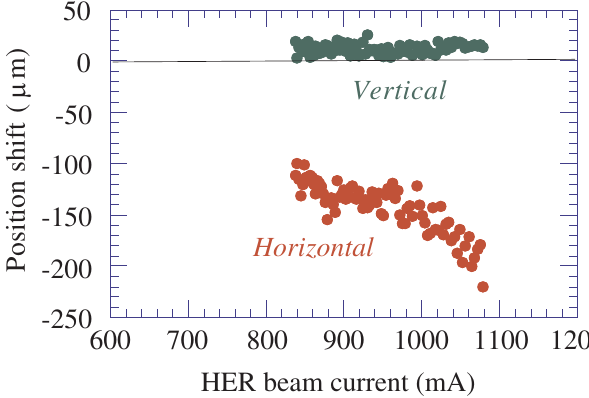
FIG. 5. (Color) Horizontal (red) and vertical (green) position shifts at LER-2 as a function of the HER total beam current, measured in a physics run in December 2003, where a peak luminosity of 1 : 1 (cid:1) 10 34 cm (cid:2) 2 sec (cid:2) 1 was